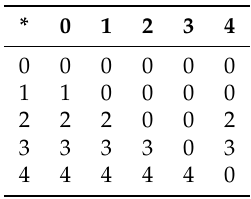
Table 1. Cayley table for the binary operation “*”.